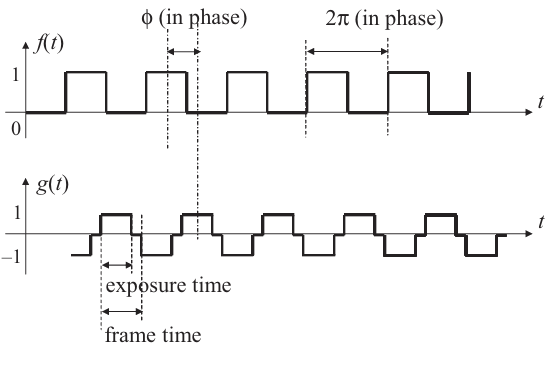
Figure 7. The reference and the output signals in shorter integration time case.